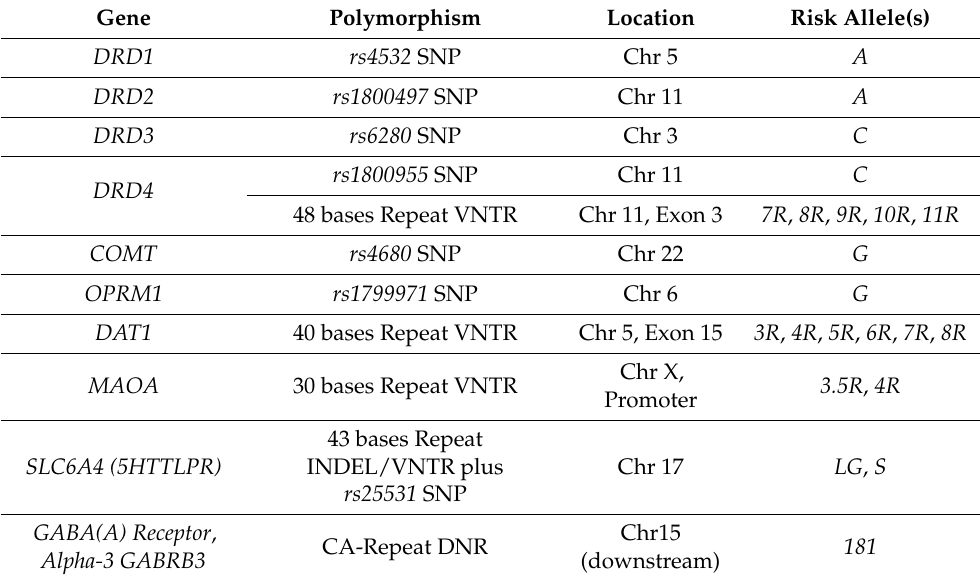
Table 5. Represents the GARS SNPS and VNTRs (snapshot) *. Gene